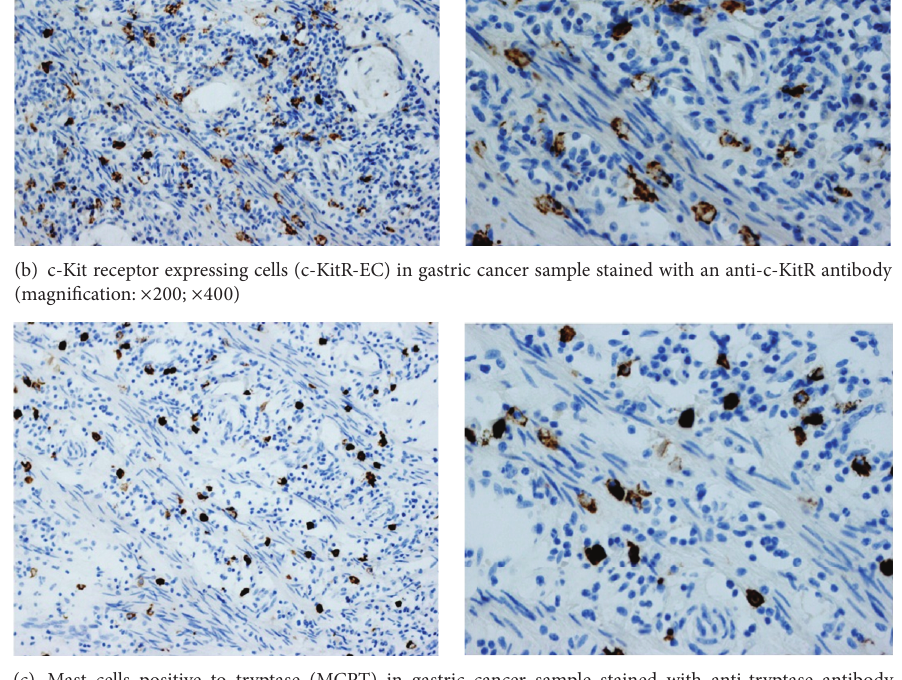
Figure 1: Representative immunohistochemical images relative to MCPT, c-KitR-EC, and MVD in gastric cancer tissue. Scale bar represents 100 𝜇